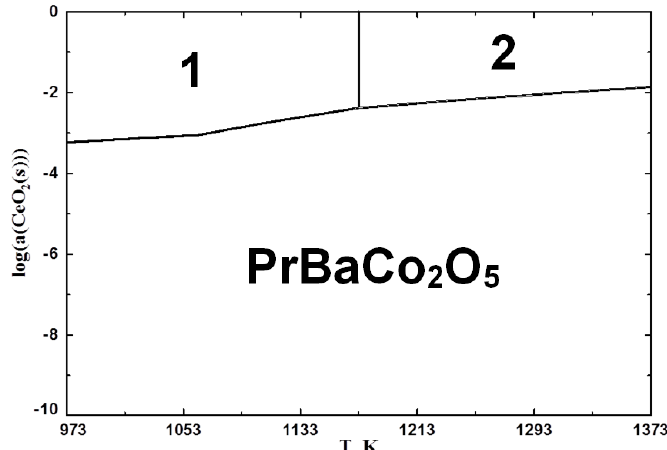
Figure 1. Equilibrium diagram calculated for PrBaCo 2 O 5 -CO 2 system at p O 2 = 0.21 atm. 1: BaCO 3 (α- phase) + PrCoO 3 + Co 3 O 4 ; 2: BaCO 3 (β-phase) + PrCoO 3 + Co 3 O 4 ; 3: BaCO 3 (β-phase) + PrCoO 3 + CoO; 4: BaCO 3 (γ-phase) + PrCoO 3 + CoO.